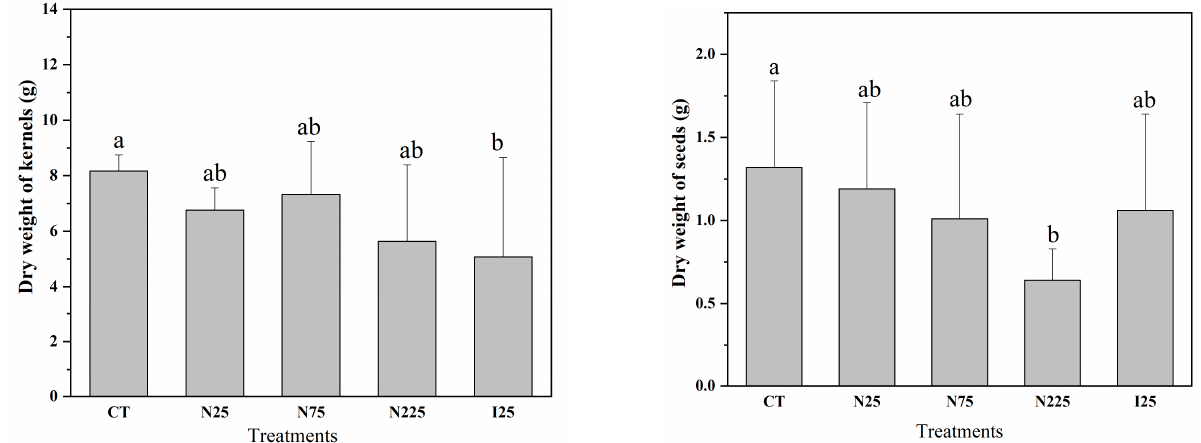
Figure 1. Dry weight of grain per plant of corn ( Left ) and soybean ( Right ). CT: control; N: CeO 2 NPs; I: CeCl 3 . Different letters stand for statistical differences between treatments at p ≤ 0.05.